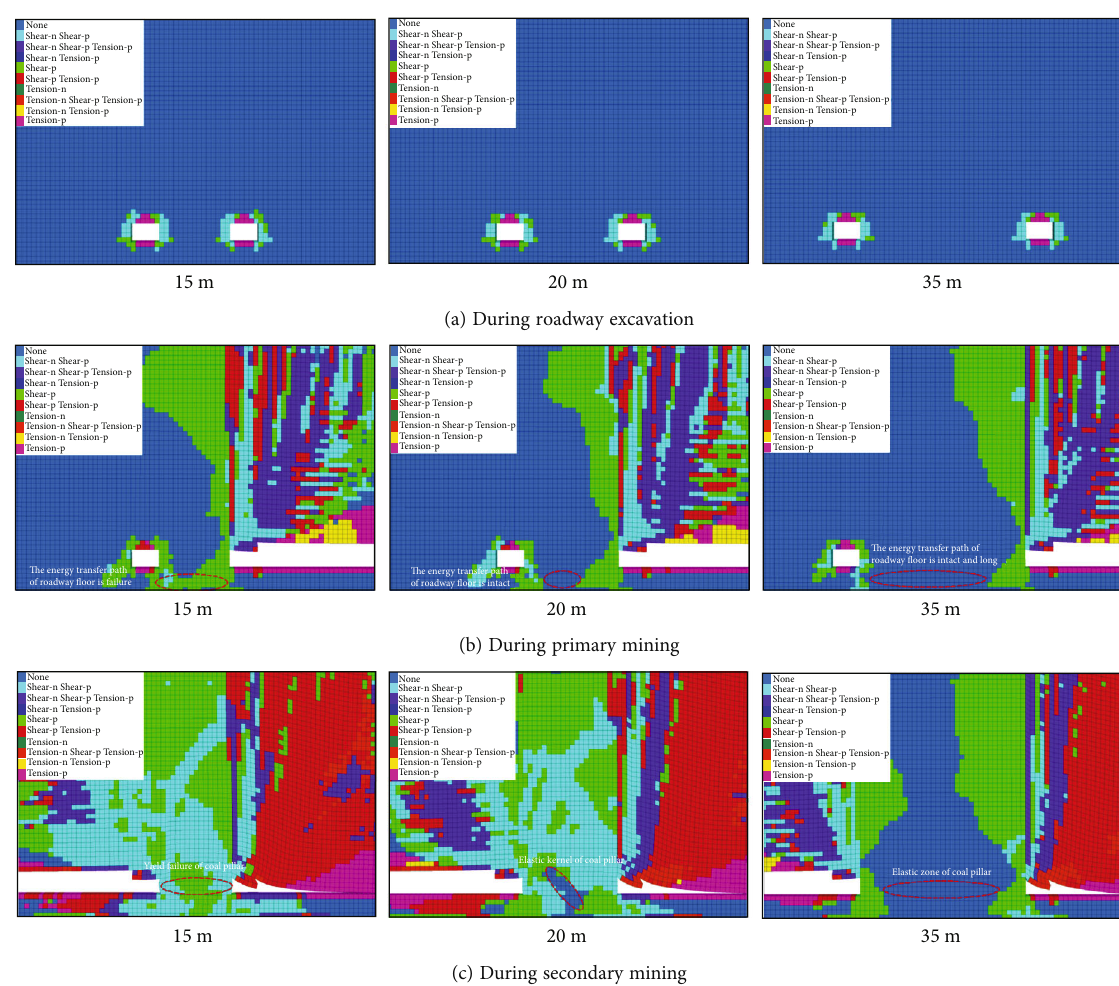
Figure 9: Distribution characteristics of the plastic zone of the roadway surrounding rock in di ff erent mining